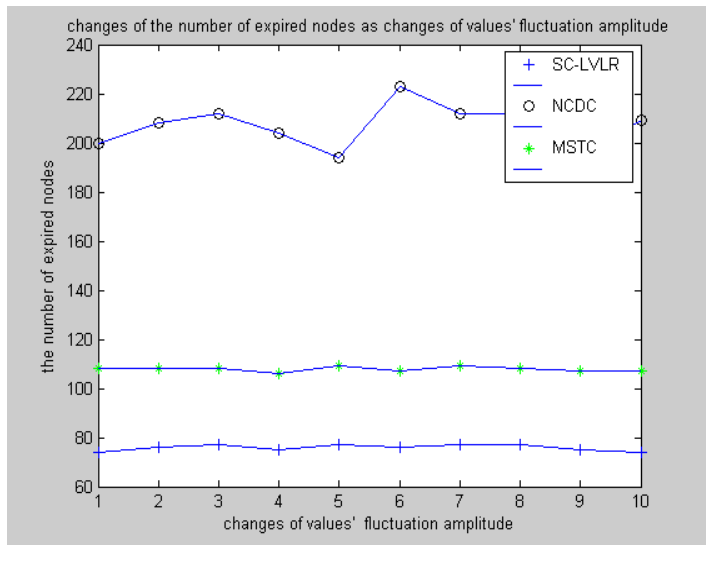
Figure 9. Changes of the number of expired nodes as changes of values’ fluctuation